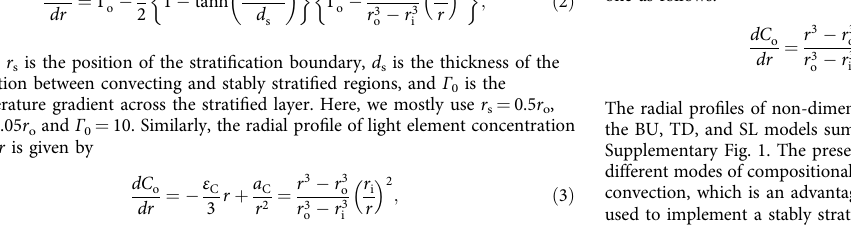
The radial pro fi les of non-dimensional heat/compositional fl ux corresponding to the BU, TD, and SL models summarized in Supplementary Table 1 are shown in Supplementary Fig. 1. The present treatment enables us to examine the effects of different modes of compositional convection while preserving the mode of thermal convection, which is an advantage over the co-density models. These pro fi les are used to implement a stably strati fi ed layer in a mathematically convenient way,